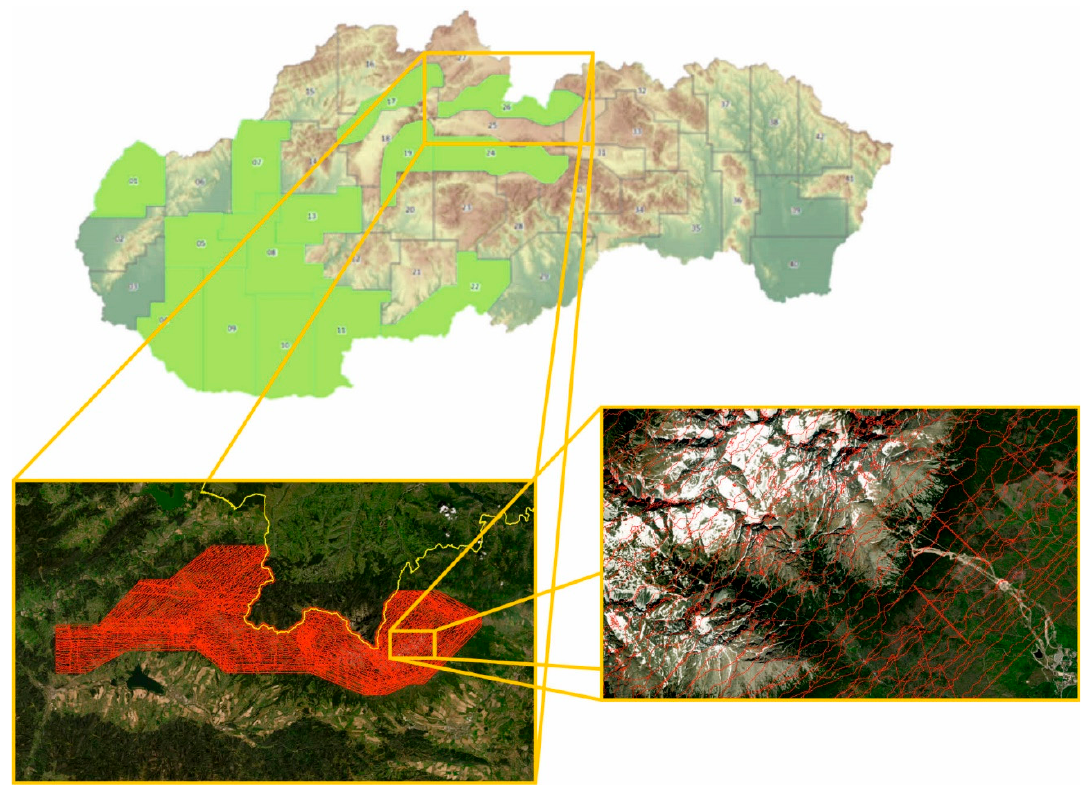
Figure 12. Map of the airborne laser scanning (ALS) sites accessed on 12.2.2020 and flight strips in the area of interest. [39].